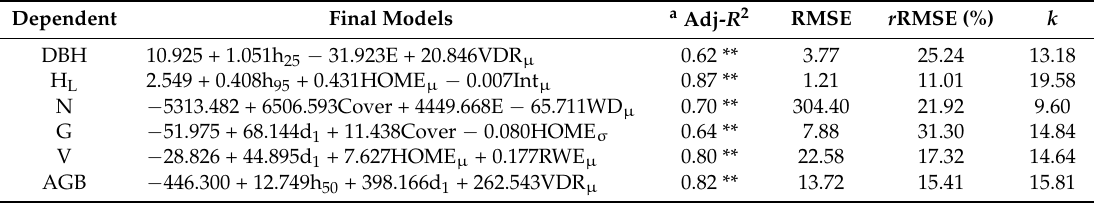
Table 6. Summary of the forest structural parameters prediction models with FWF LiDAR metrics (integration of point cloud based metrics and full-waveform based metrics) and plot-level accuracy assessment results.